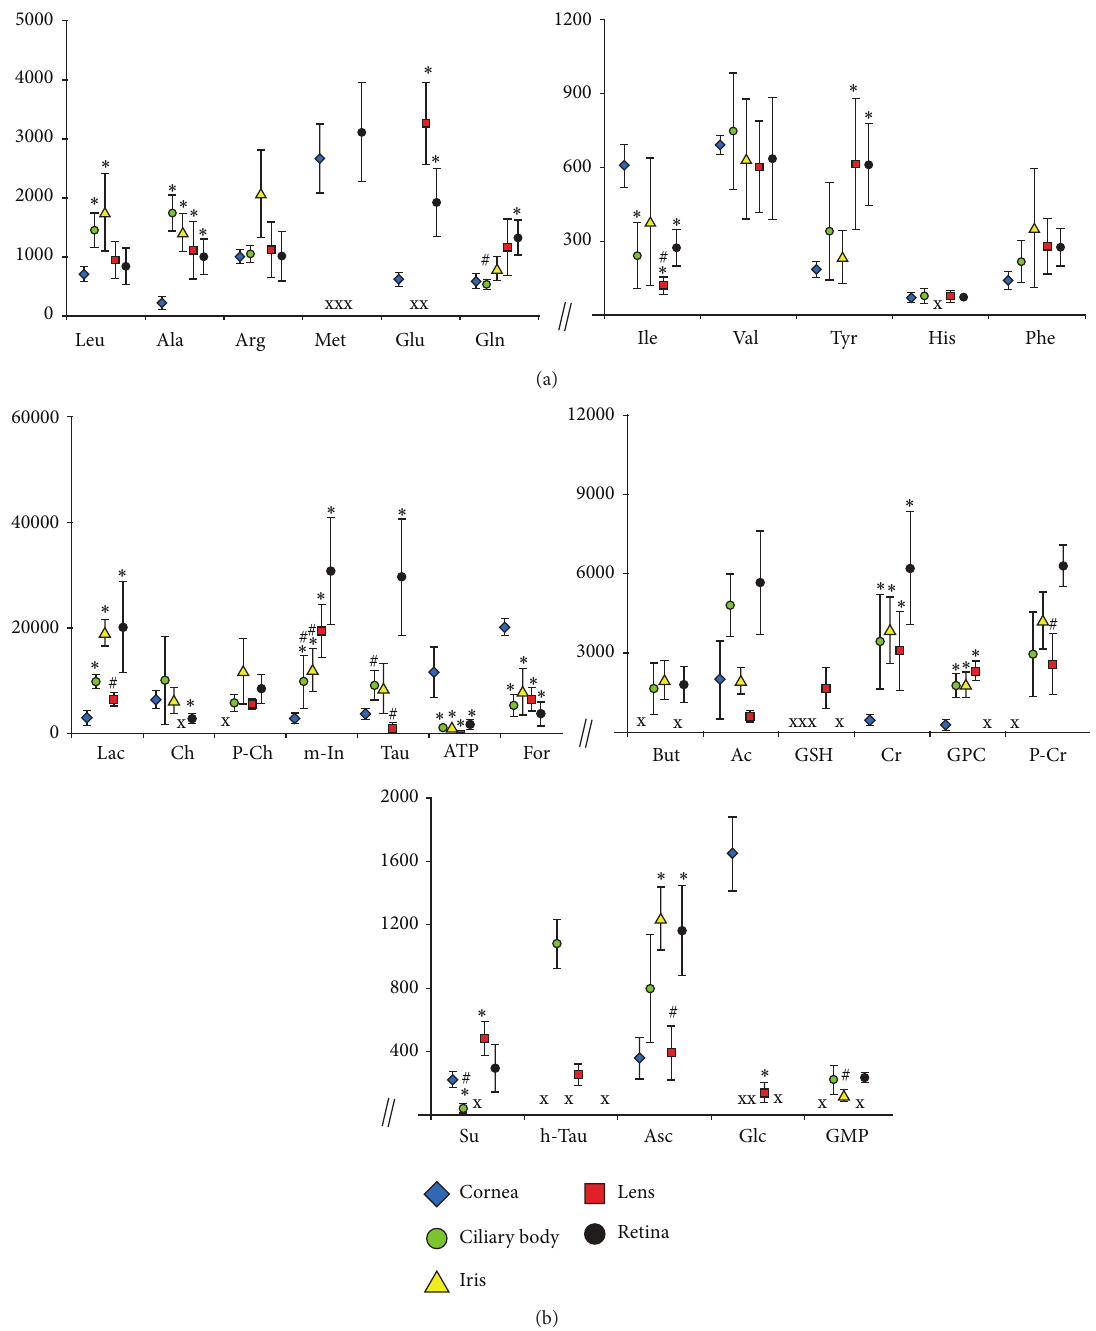
Figure 3: The contents of assigned biochemical compounds in various eye tissues. (a) amino acids; (b) nonamino acid compounds. Data are means ± SEM of HR MAS 1 H NMR peak integrals divided by tissue wet weight; ∗ 𝑃 < 0.05 versus the respective cornea group value; # 𝑃 < 0.05 versus the respective retina group value; X—no detectable metabolite peak in the respective NMR spectra. For metabolite labels see legend for Figure